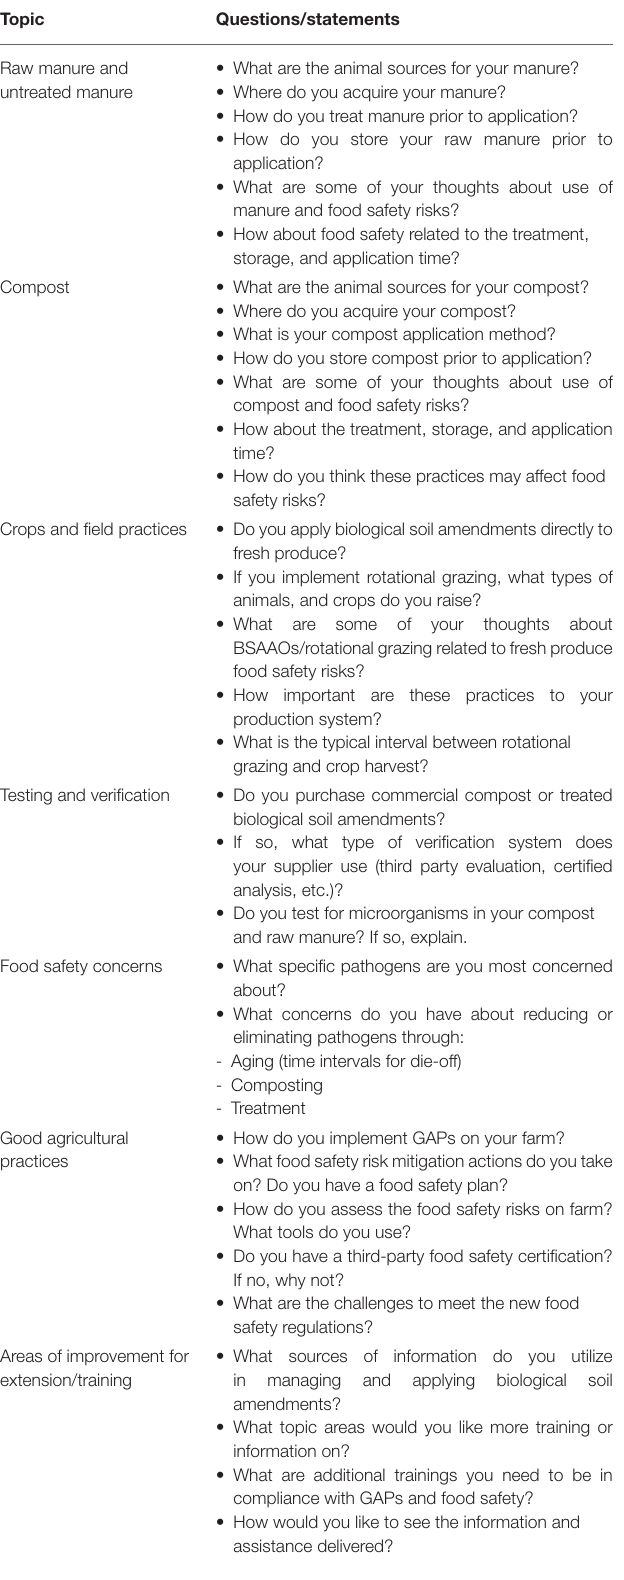
TABLE 1 | Questions related to use of BSAAOs and food safety risks included in the in-person focus group